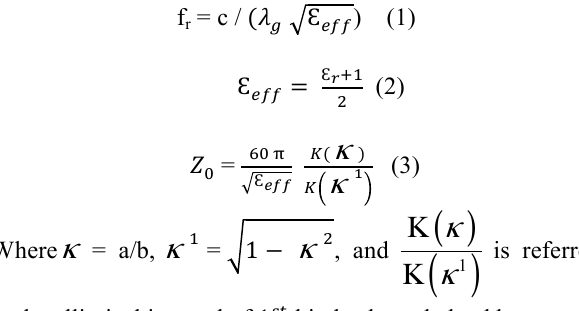
Figure 3: (a). Various design stages with current distribution (b). Frequency versus |S